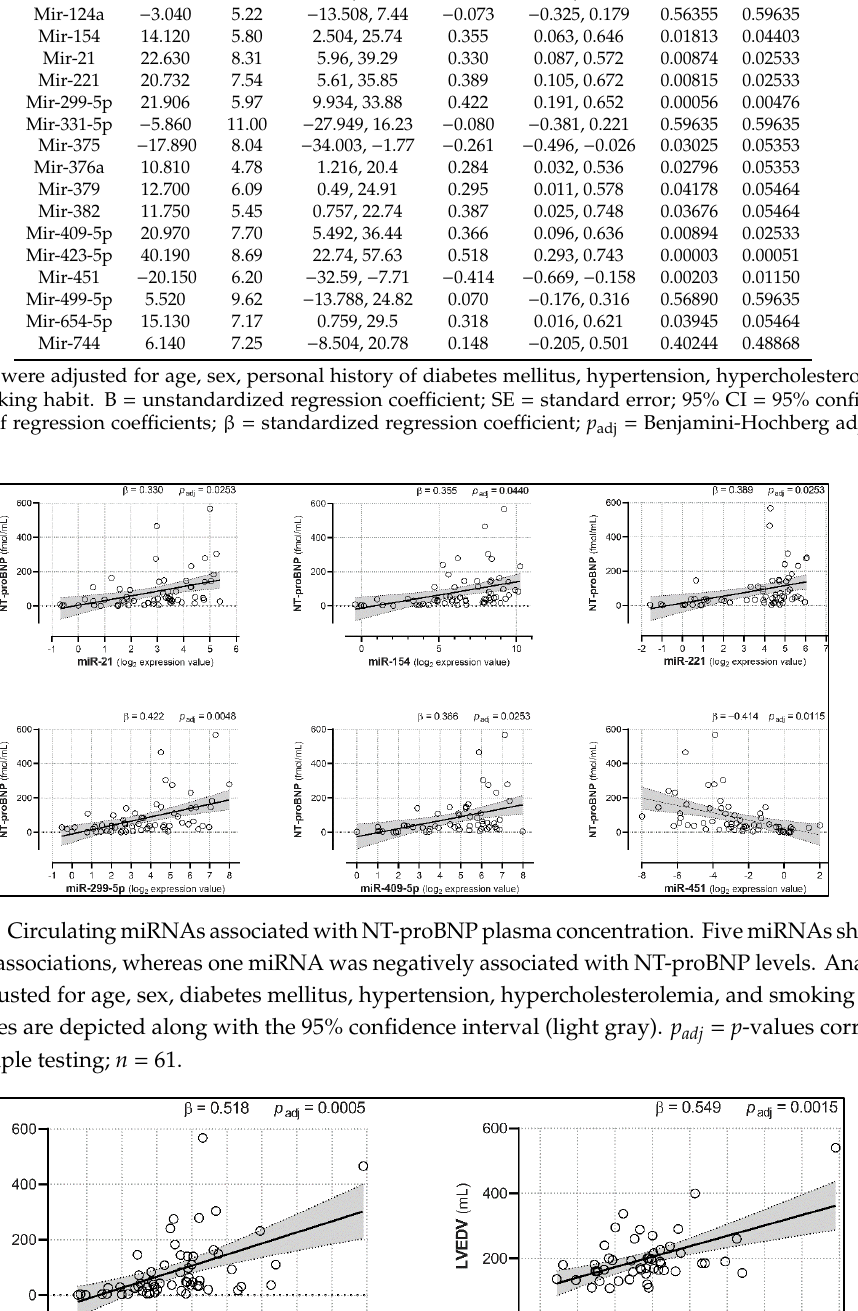
interval (light gray). p adj = p -values corrected for multiple comparisons; n = 61.